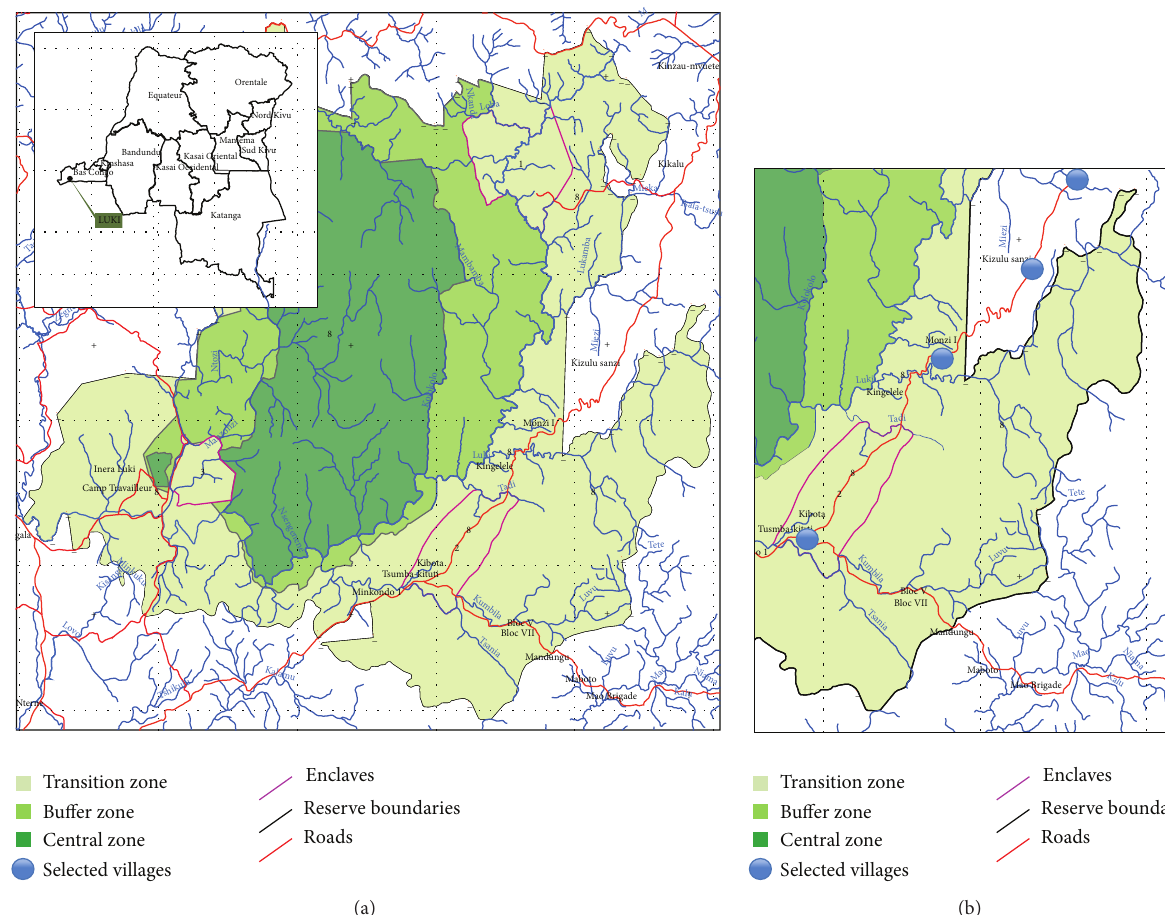
Figure 1: (a) Map of the Luki Biosphere Reserve and its designated zones. (b) Map showing the location of the villages selected for the study.